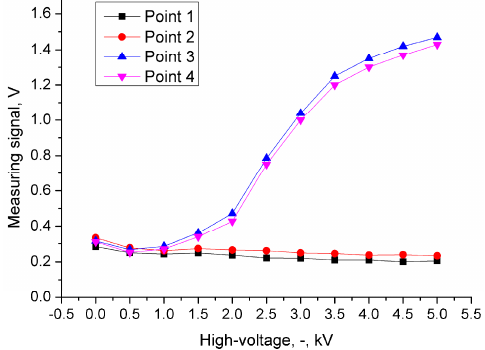
Figure 9. Peak ionic concentration change at the four points under various voltages.